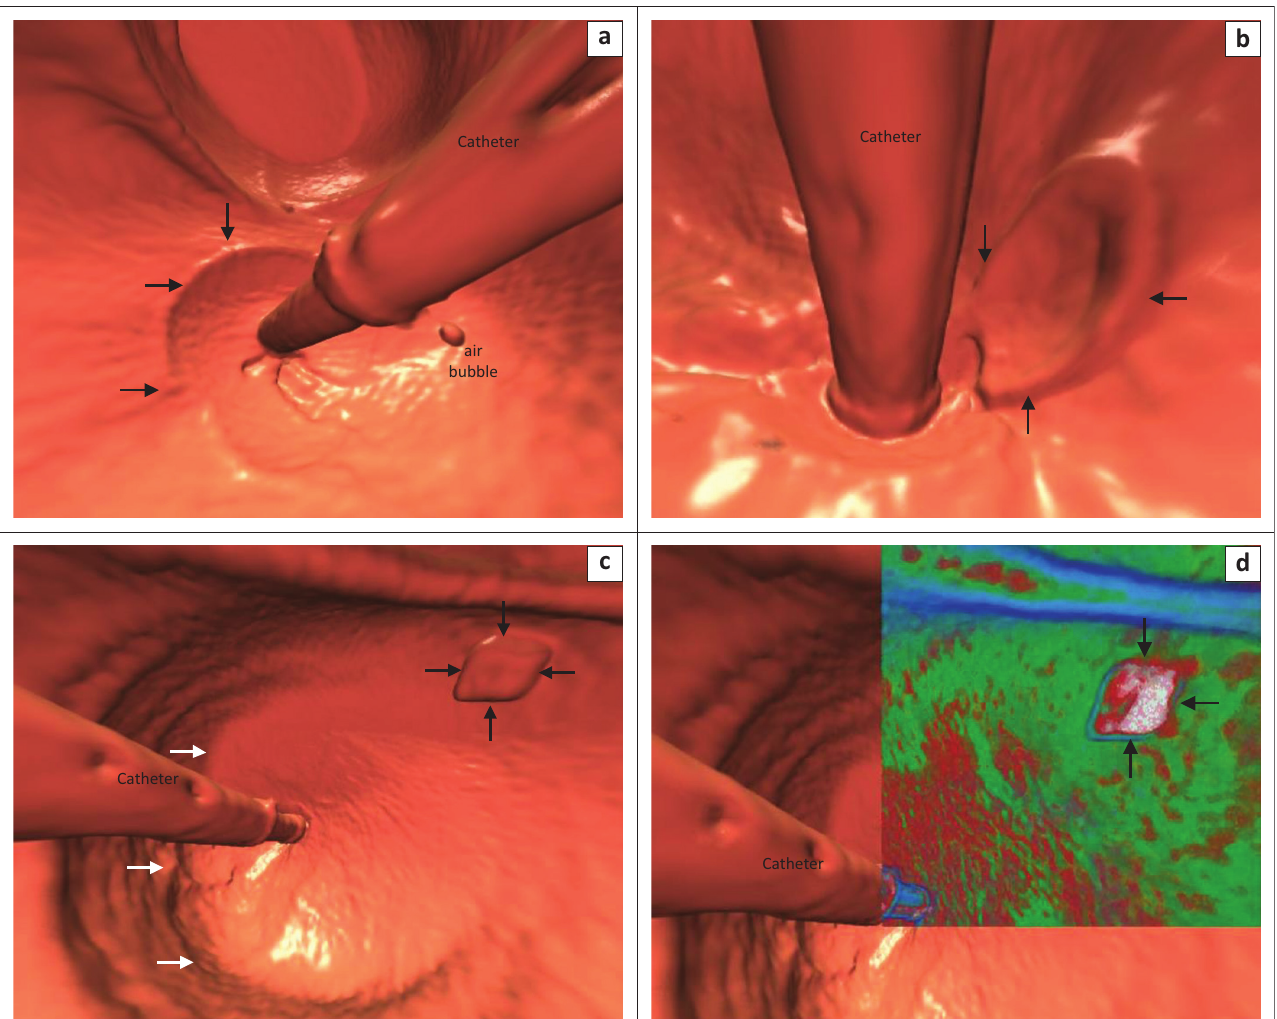
FIGURE 7: (a) 3D view showing meniscal defect (black arrows) due to balloon; (b) 3D view showing meniscal defect (black arrows) from inflated balloon; (c) 3D view showing polypoidal lesion (black arrows). White arrows show margin of meniscal sign; (d) TD shows mainly barium (black arrows) indicating stool.